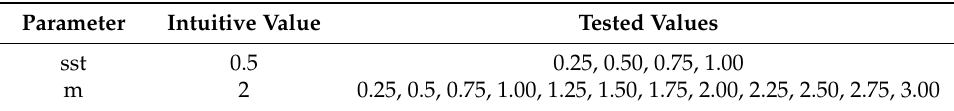
Table 2. Adopted parameter sst and m values.